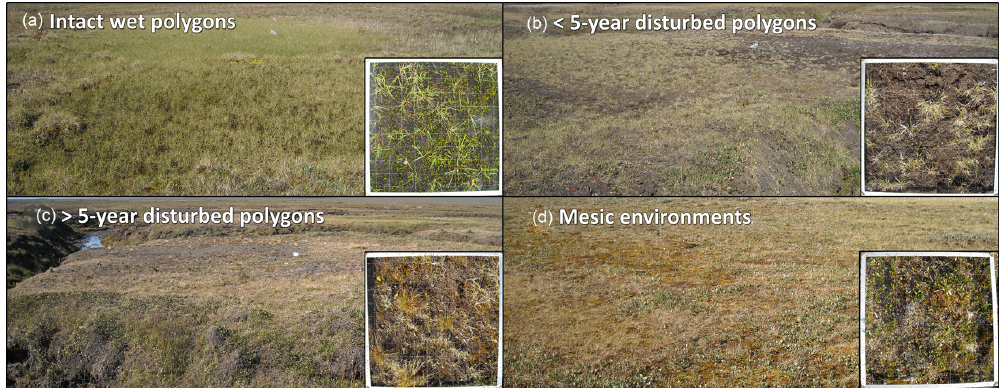
Figure 2. The four habitat types studied in the Qarlikturvik valley, Bylot Island, Nunavut. The close view at the bottom right of each picture represents the 70cm × 70cm quadrats that were used to determine species richness and abundance in each sampling site.